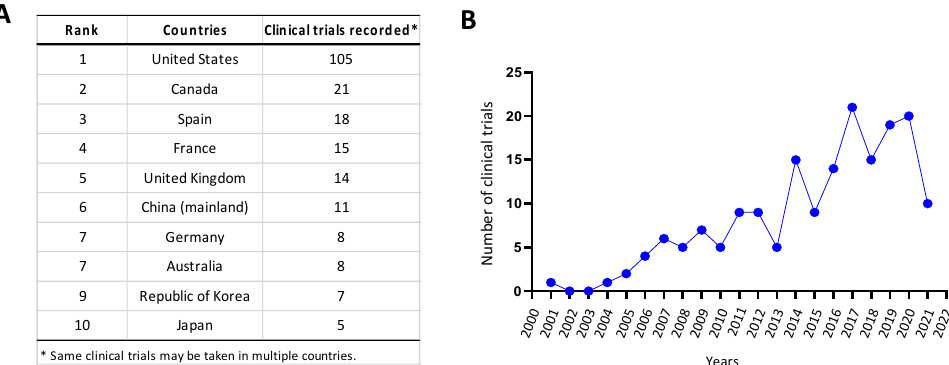
Figure 1. Number of registered clinical trials on oncolytic viral studies from clinicaltrials.gov in top 10 countries ( A ) from 2001 to 2021 ( B ). Note that the data of 2021 only cover clinical studies registered until 31 May 2021. Search keywords ‘oncolytic’ and ‘tumor’ found 182 records in total with five excluded for not involving oncolytic virus.